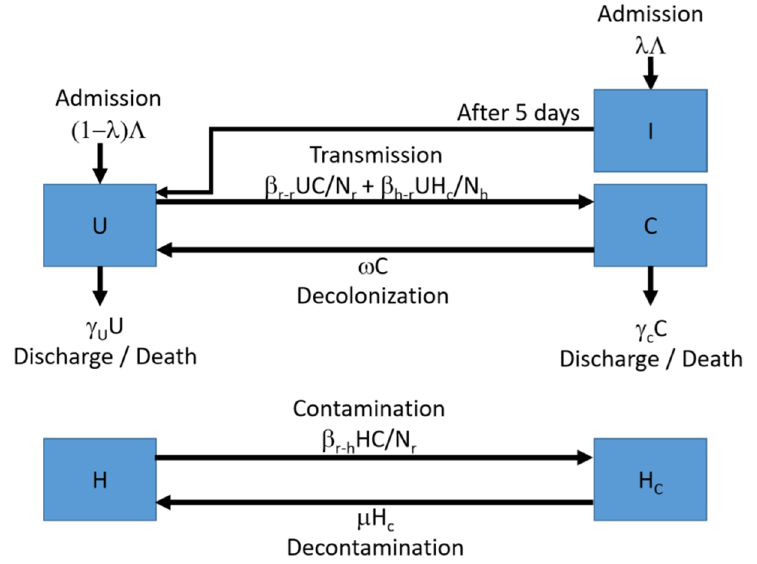
Figure 6. Schematic of the extended model for screening-and-isolation upon